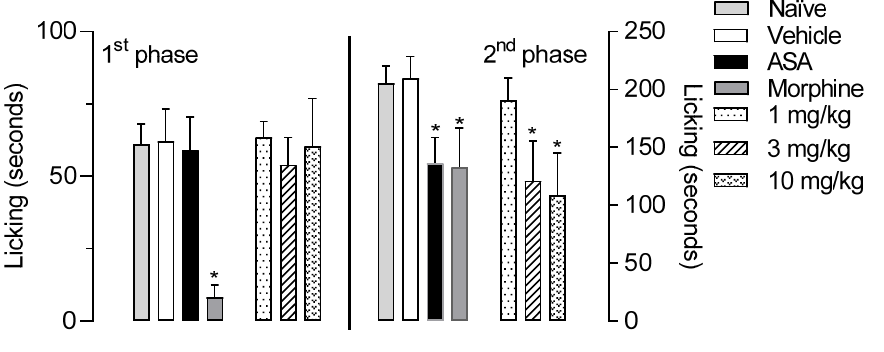
Figure 6. Antinociceptive effects of LASSBio-2265 ( 11 ) on formalin-induced licking behavior in mice. Mice were pretreated orally with LASSBio-2265 ( 11 ), morphine (2.5 mg/kg), acetylsalicylic acid (ASA, 200 mg/kg), or the vehicle, and the time spent licking the formalin-injected paw was recorded (in seconds) in the first phase (0–15 min post-formalin injection) and second phase (15–30 min post- formalin injection). The results are presented as the mean ± SD (n = 7 mice per group). Statistical significance was calculated by one-way ANOVA followed by Tukey’s test. * p < 0.05 compared with